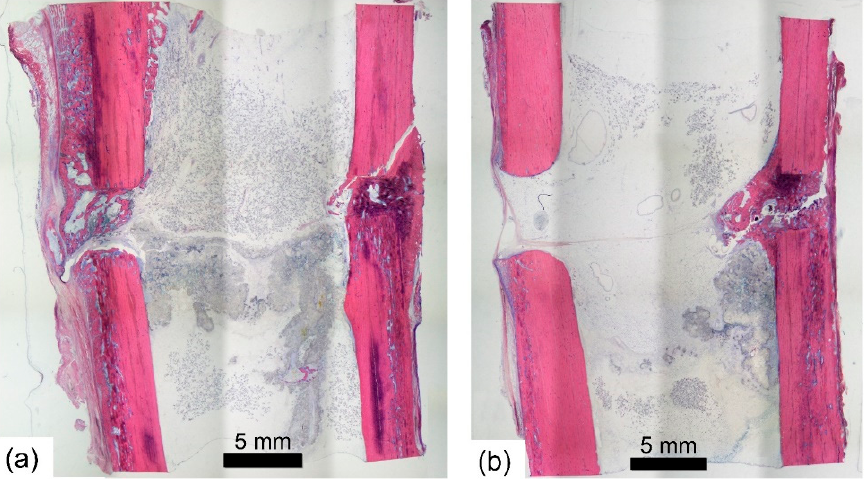
Figure 8. Giemsa-eosin-stained sections showing the experimental defects of both animals (immediate ( a ) and delayed ( b ) stimulation). In both animals the isolated mobile fragment was vital.